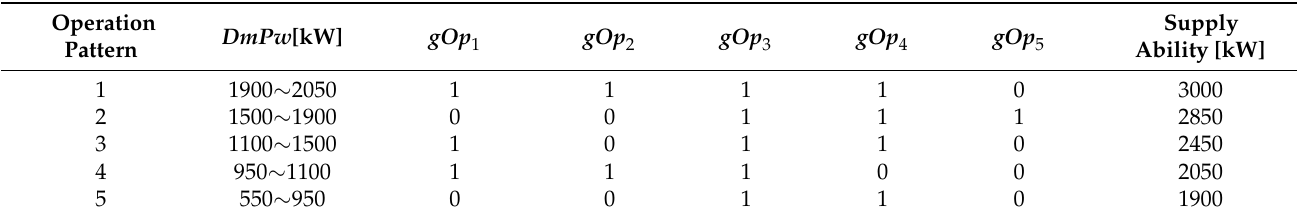
Table 5. The unit selection of the five units of medium-speed DGs operated by the conventional load sharing method.